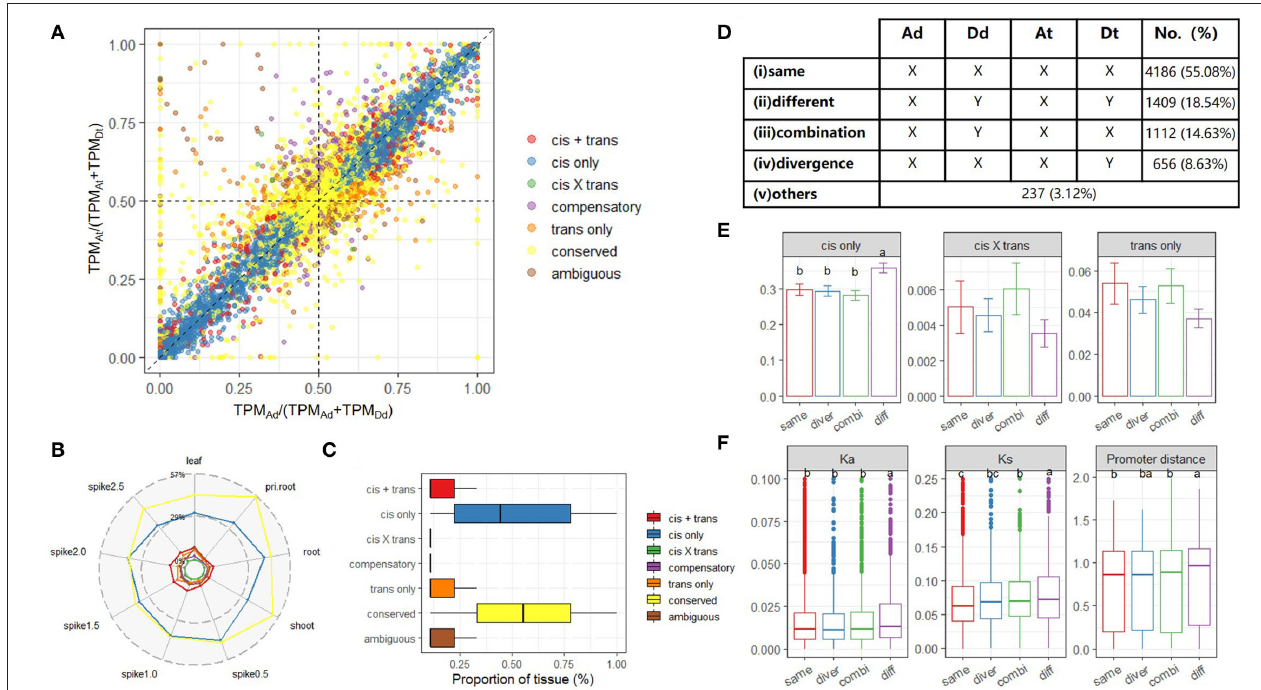
FIGURE 4 | Homoeolog-specific expression (HSE) analysis across tissues/stages. (A) A scatterplot shows the relationship between the expression ratio of A allele at a diploid level [ x -axis, TPM Ad /(TPM Ad + TPM Dd )] and that of A homoeolog at a tetraploid level [ y -axis, TPM At /(TPM At + TPM Dt )] for genes in root tissue. The colors represent different HSE patterns determined for each gene; (B) Proportion of homoeolog pairs classified into each HSEpattern; (C) The conservation degree of different HSE patterns among tissues; (D) The number of homoeolog pairs among five co-expression groups of quadruplets (orthologs Ad and Dd as well as homoeologs At and Dt) in AT2 based on the co-expression network. For a given module, “X” means a gene is belonged to this module, whereas “Y” means a gene is not in such a module; (E) The proportion of different types of HSE genes in four co-expression groups. Error bars indicate the variance among nine tissues. One-way ANOVA and multiple comparisons were performed to compare the ratio among co-expression groups ( p -value < 0.05); (F) Evolutionary features of homoeologs belonged to different co-expression groups are denoted in each sub-panel, including Ka (non-synonymous mutation), Ks (synonymous mutation), and sequence divergence of the promoter region. One-way ANOVA is used to compare the difference in each evolution feature among co-expression groups ( p -value <